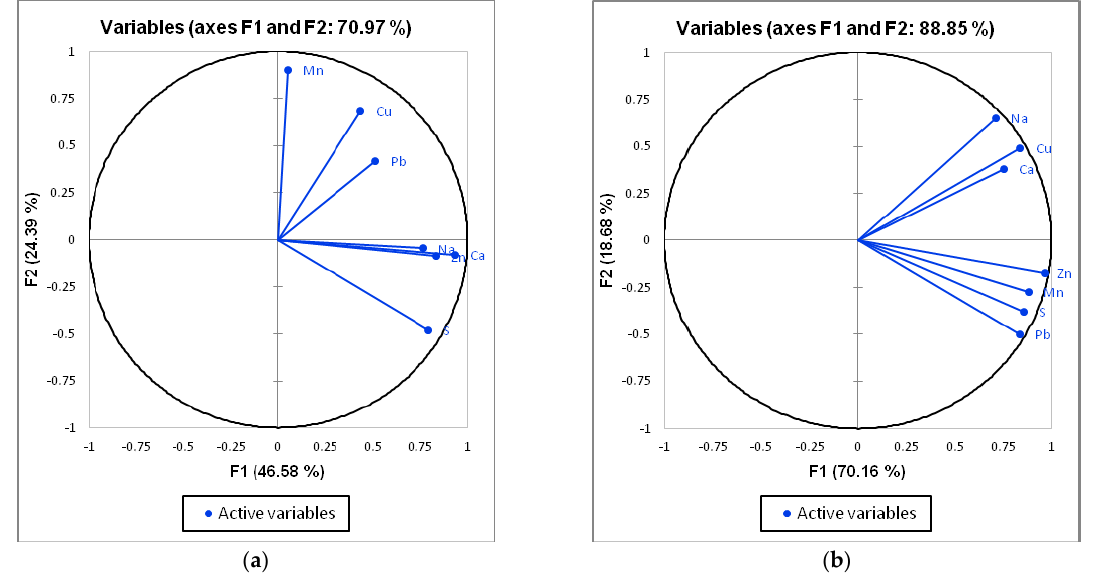
Figure 4. Variable plot in the system of the first two factor axes for the soil after the first ( a ) and second ( b ) year of cultivation of giant miscanthus.